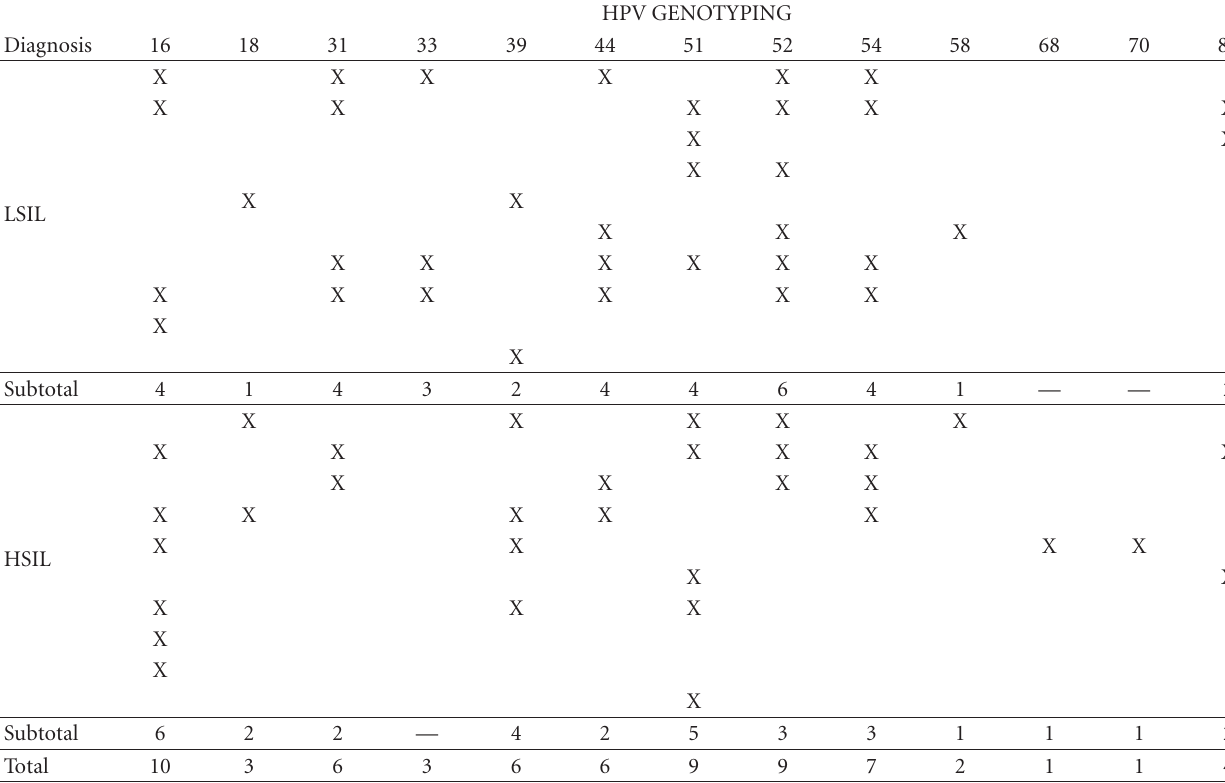
Table 5: HPV Genotyping in cytologic specimens of women with LSIL and HSIL. HPV